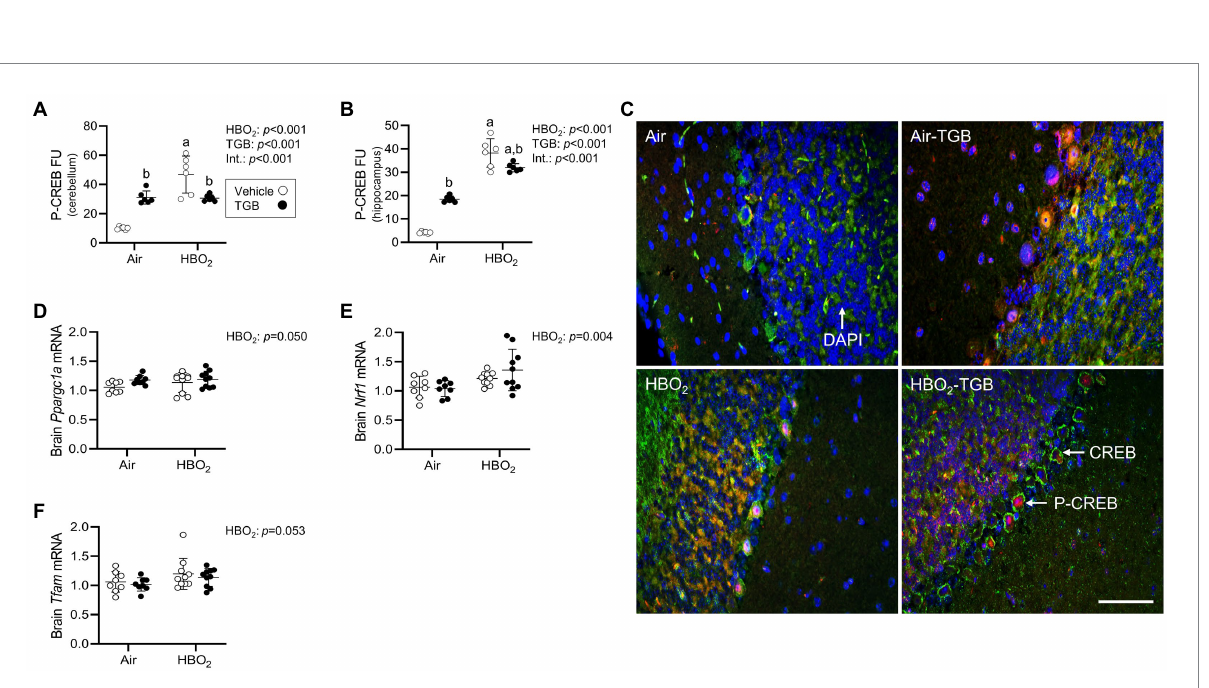
FIGURE 7 Initiation of mitochondrial biogenesis signaling in mice exposed to extreme HBO 2 . Mice were pretreated with 0.9% NaCl or TGB (4.8 mg/kg body weight) 30 min before exposure to air or 5 ATA oxygen for 30 min. (A,B) Quantification of phosphorylated cAMP response element-binding protein at Ser-133 (pCREB) in the cerebellum and hippocampus. (C) Representative images from cerebellum. pCREB (red), CREB (green), and DAPI (blue). Scale bar = 20 μ m. (D–F) Peroxisome proliferator-activated receptor gamma coactivator 1- α ( Ppargc1a ), nuclear respiratory factor 1 ( Nrf1 ) and mitochondrial transcription factor A ( Tfam ) mRNA expression in brain homogenates ( n = 8–10/group). Main effect of a HBO 2 and b TGB, p <